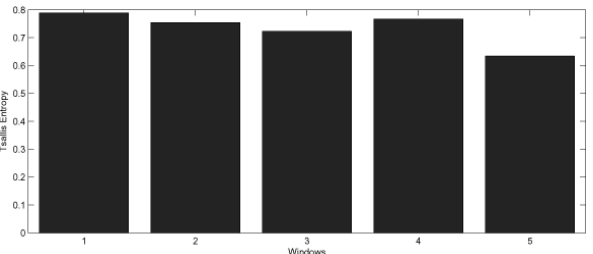
Fig. 11. Entropy values for five window intervals for the most dis- turbed day in January 2011 from detrended TEC taken from Birnin